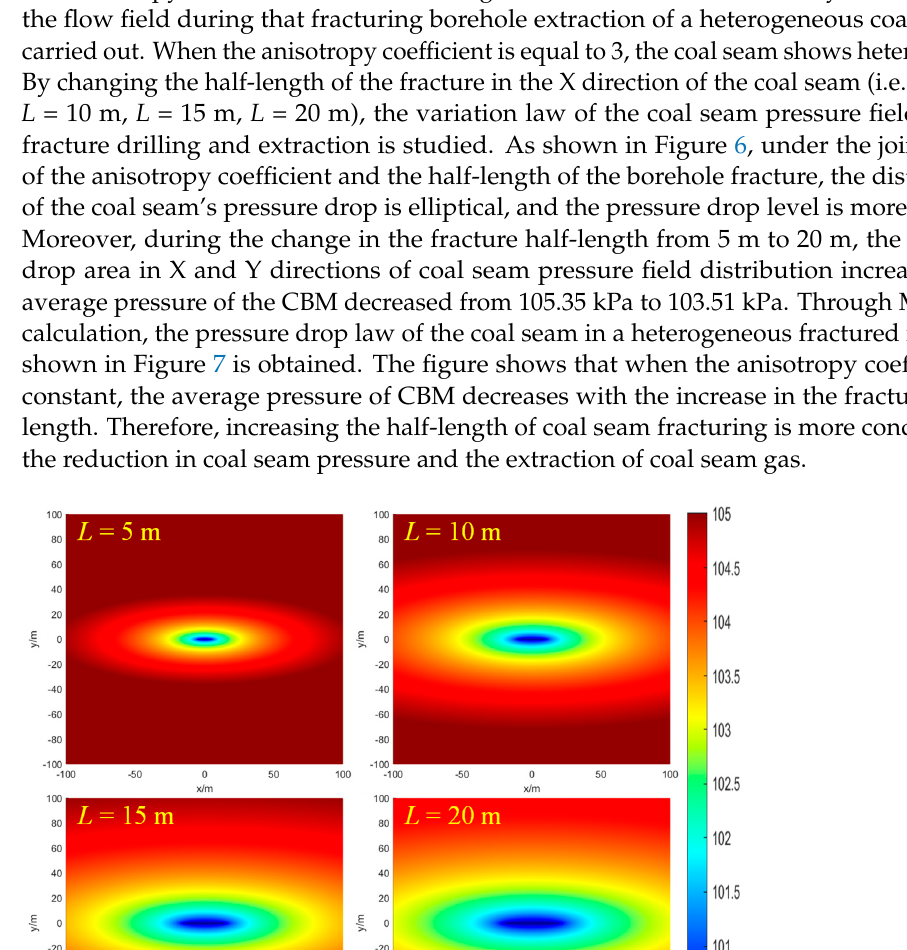
Figure 5. Effect of anisotropy on CBM pressure.